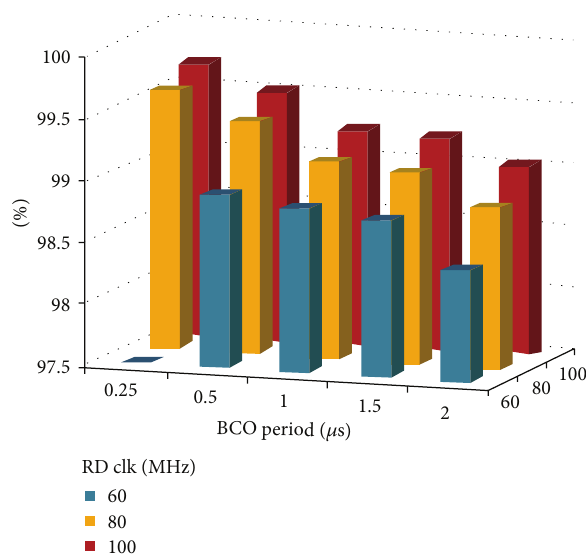
Figure 24: Freezing efficiency plot. The efficiency drop in lower- left corner is due to scan buffer overflows. This implies no hit loss but a longer average sweeping time and a reduced time resolution for some events. Freezing efficiency results in %. 1 𝜇 s simulated at 100 MHz/cm 2 , corresponding to more than 30 khit generated on a 80 × 256 submatrix, 40 𝜇 m pitch, no